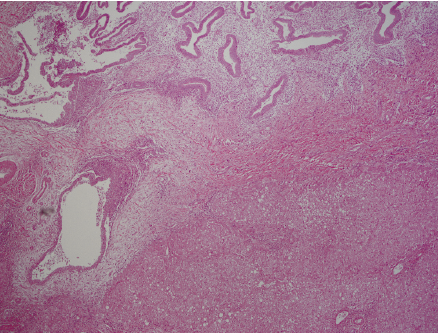
Figure 1: Computed tomography showing 3.2 x 4.0 x 1.8 cm multiseptated cystic lesion in the left hepatic lobe.